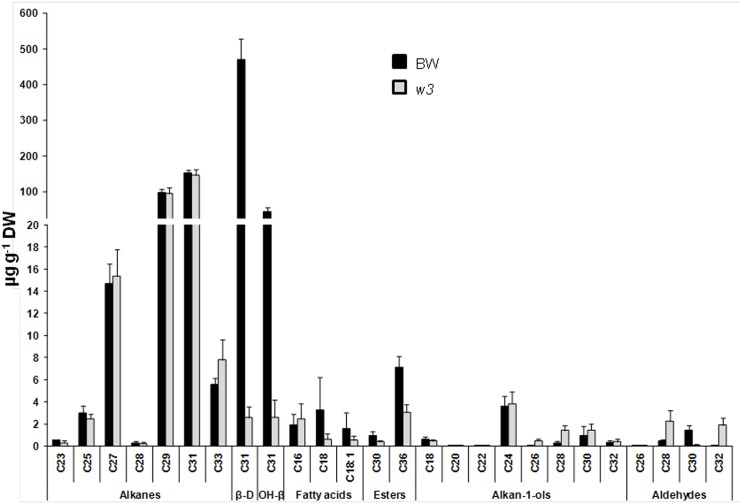
Variation of wax homologues between BW and w3 mutant.Carbon atom numbers of alkanes, β-diketones, primary alcohols (alkan-1-ols), fatty acids, wax esters, and aldehydes are indicated on the x-axes. Their contents are indicated on y-axes as μg per g dried tissue (dry weight, DW). The error bars indicate standard deviation of the mean calculated from five biological replicates. β-D, β-diketone; and OH-β, hydroxy-β-diketones.